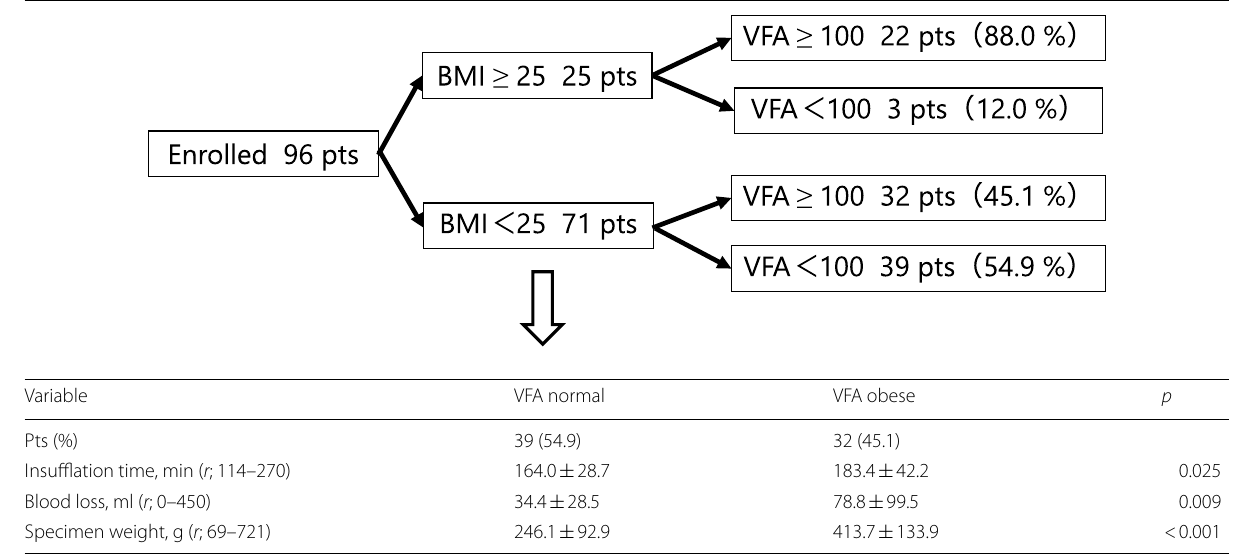
Table 5 Operative data of obese and normal groups classified by VFA in non-obese patients (BMI < 25)